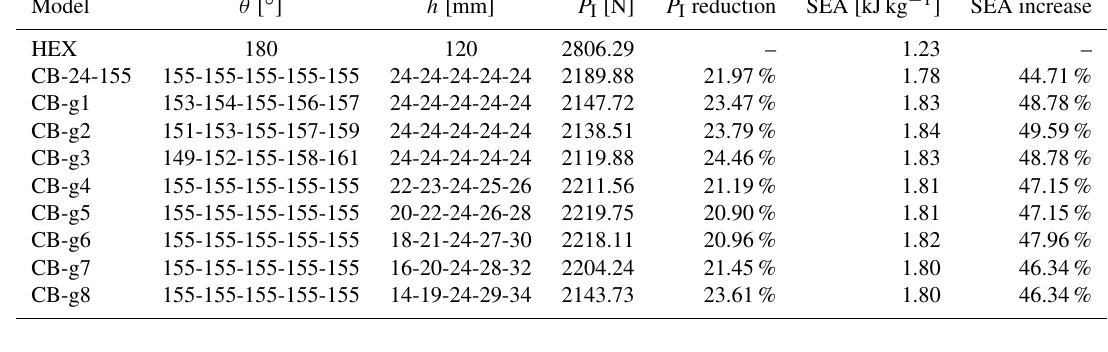
Table 2. Geometrical parameters and numerical results of graded origami crash boxes. Model